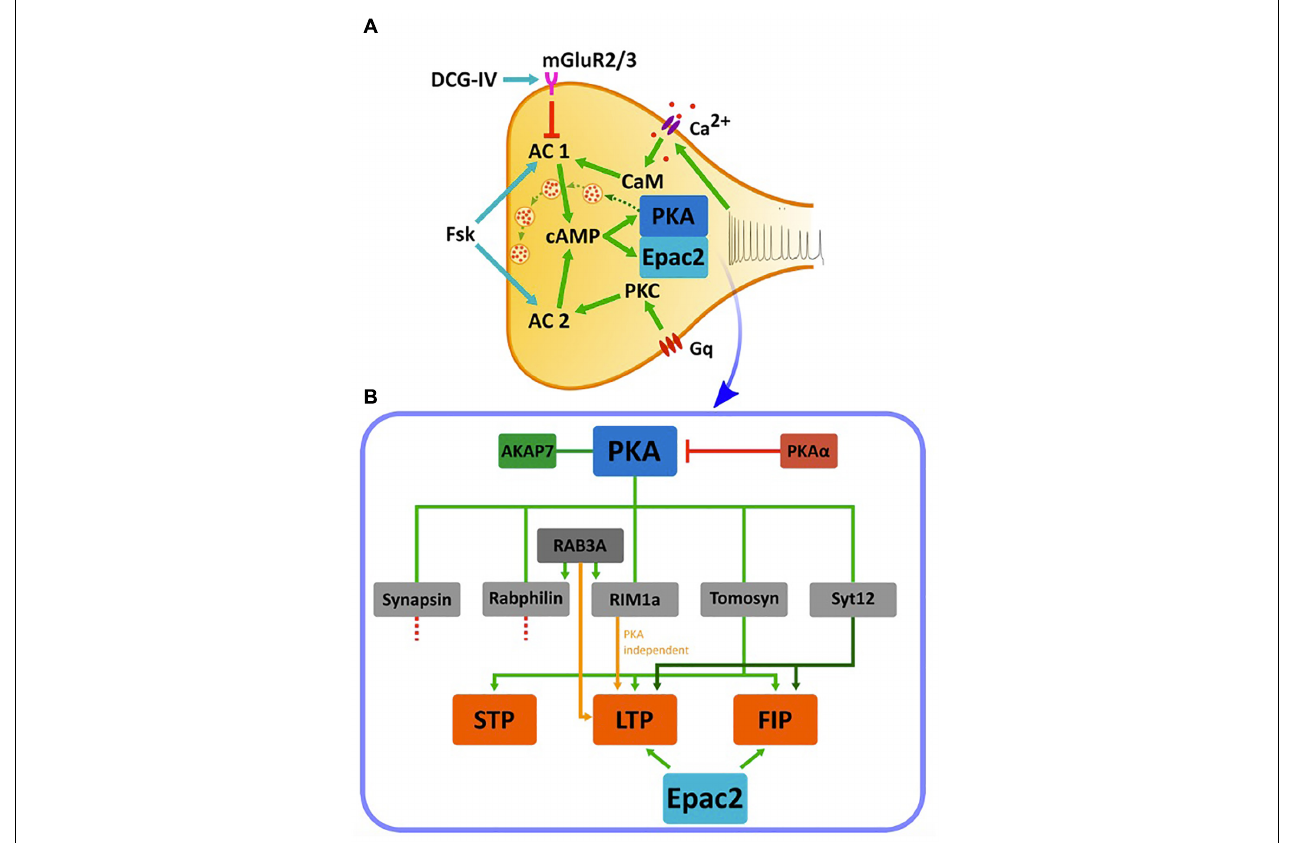
FIGURE 3 | cAMP cascades and cAMP-dependent synaptic plasticity in the MF synapse. (A) Cascades of activation of cAMP, PKA, and Epac2 in the MF terminal. A train of action potentials arriving at the MF synapse triggers a calcium influx through voltage-dependent calcium channels and subsequent activation of CaM that activates cAMP synthesis by AC1. AC1 acts on PKA or Epac2 to up regulate synaptic transmission (dashed green arrows between vesicles). Application of FSK activates both AC1 and AC2 and elevates cAMP. AC2 is also activated by PKC following the activation by a G-coupled protein. Application of DCG-IV, an agonist to mGluR2/3, leads to inhibition of AC1. Green arrows: activation, red arrow: inhibition, blue arrows: application of pharmacological reagents. (B) Downstream PKA cascades and their relation to synaptic plasticity. PKA activity is dependent on the anchoring protein AKAP7, and is inhibited by the negative regulator PKA α . PKA, in turn, phosphorylates multiple proteins including synapsin, rabphilin, tomosyn-1, synaptotagmin12 (Syt12) and RIM1a. Of these, deletion of synapsin and rabphilin does not impair MF synaptic plasticity. Ablation of RAB3A, although not a direct PKA target, and RIM1a abolishes MF-LTP but does not affect STP and FSK-induced potentiation (FIP). Synaptotagmin-12 KO abolishes MF-LTP and impairs FSK-induced potentiation but do not affect STP, while deletion of tomosyn-1 abolishes MF-LTP, impairs FSK-induced potentiation and also affects STP. Epac2 manipulation also abolishes LTP and impairs FSK-induced potentiation. STP- short-term potentiation, LTP- long-term potentiation, FIP- FSK-induced potentiation. Orange arrow represent PKA-independent pathway, Green arrows shades represent different pathways.